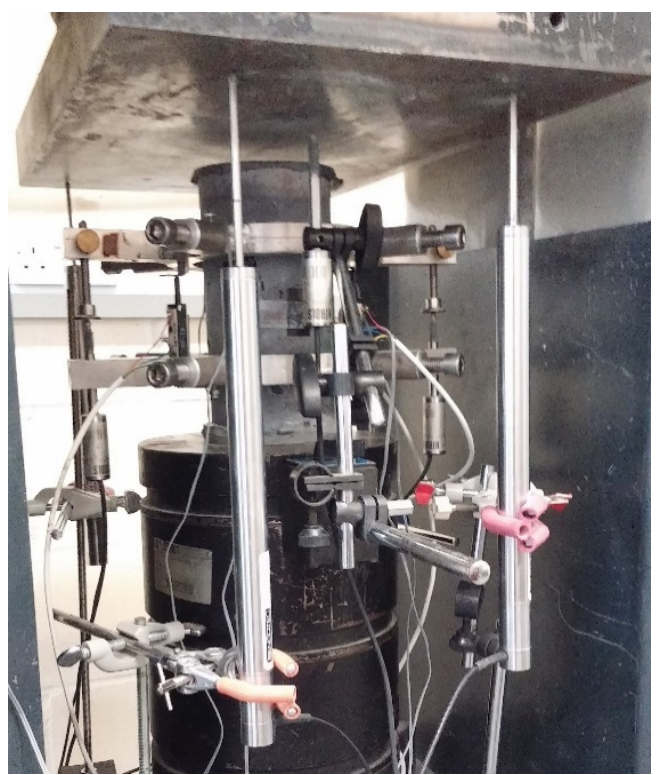
Figure 1. Set-up of uniaxial compression test.